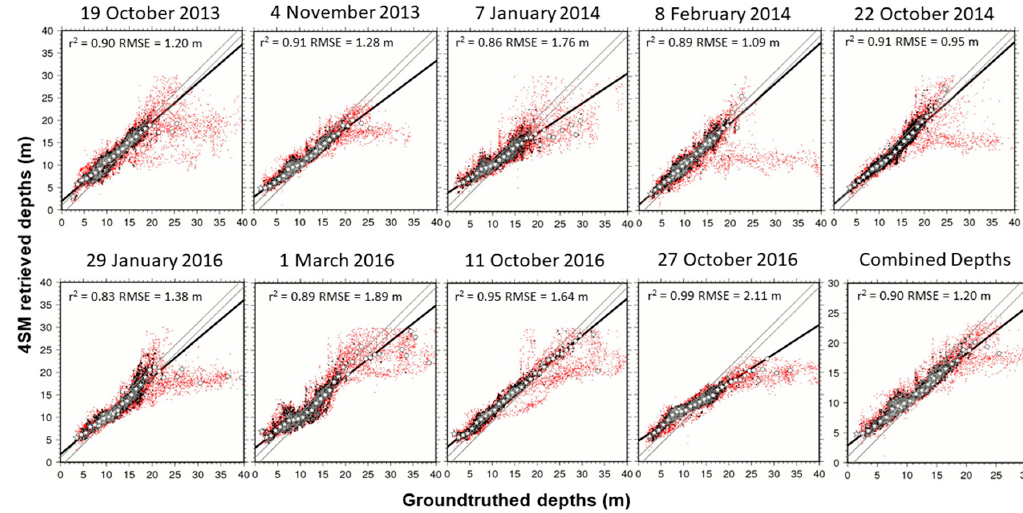
Figure 6. Scatterplots of 4SM retrieved depths vs tide corrected groundtruthed depths for nine scenes, plus combined depth (lower right). Please note the different scale in the combined depths plot.